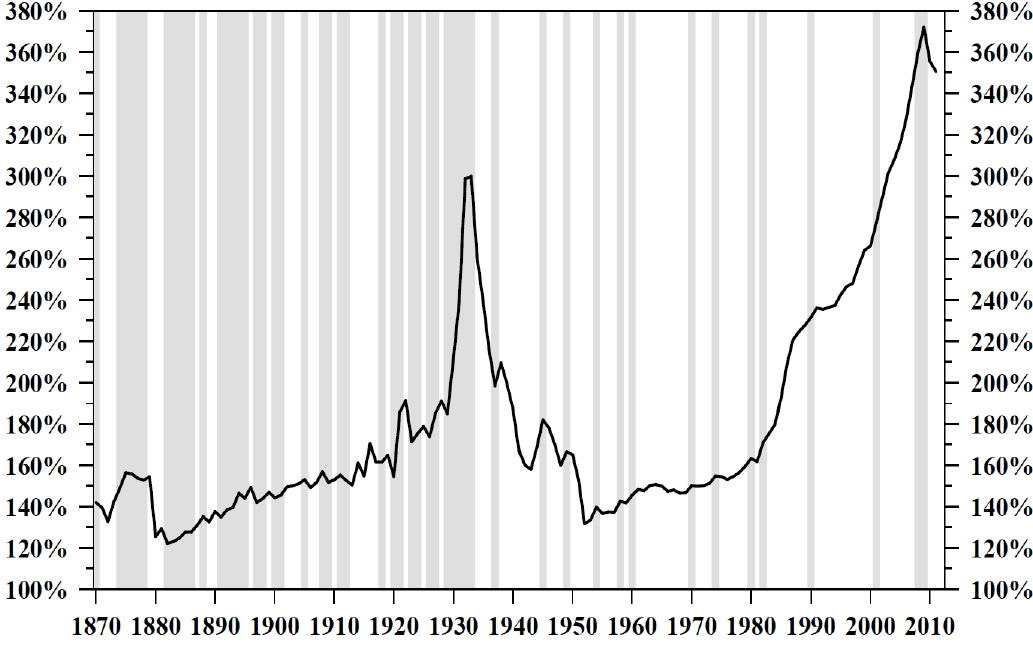
Figure 5. The U.S. total credit market debt as a % of GDP (includes Government and Government Sponsored Entities, Households, Corporates and Financials). Source: